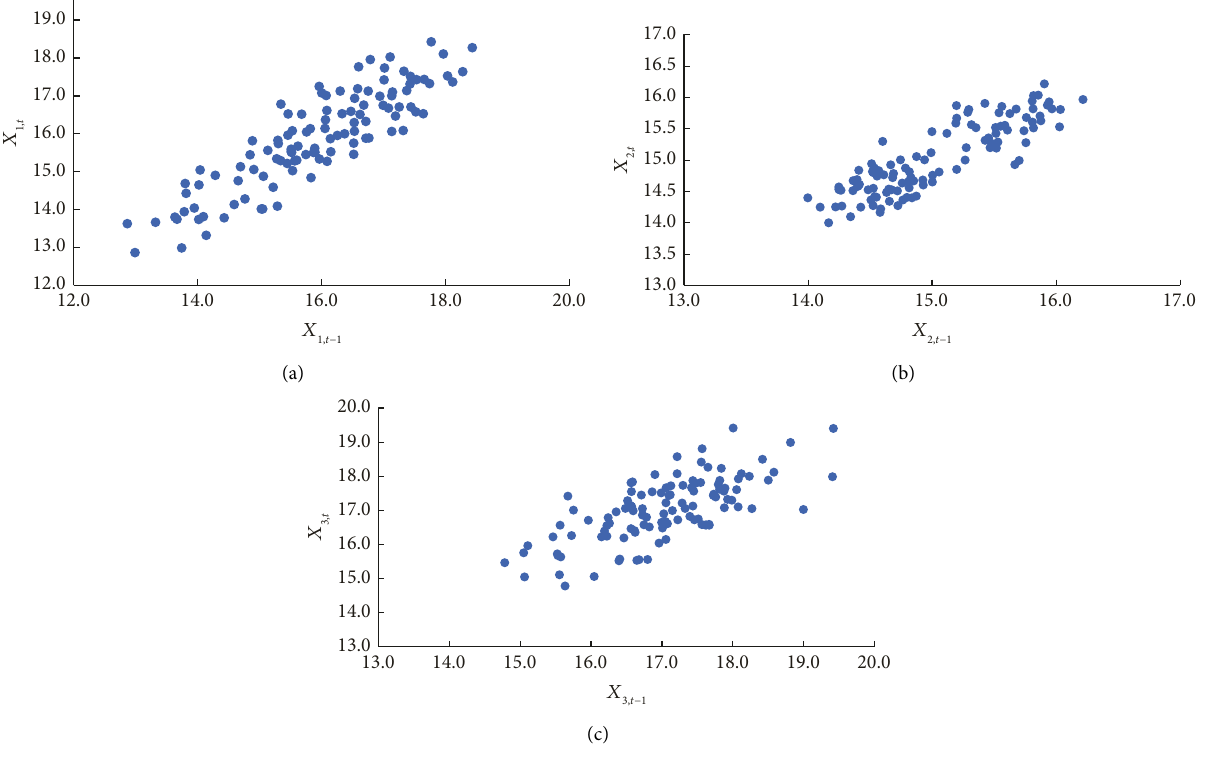
Figure 2: Lag-1 scatter plot of (a) X